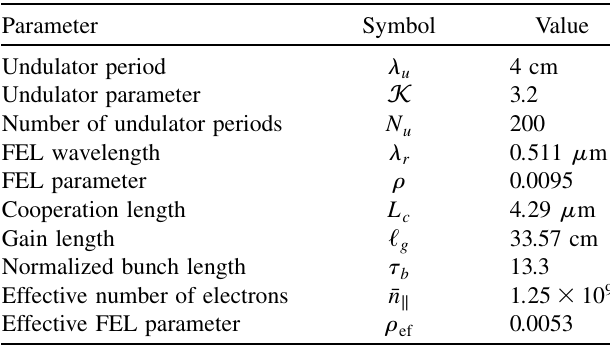
TABLE II. Main parameters of the